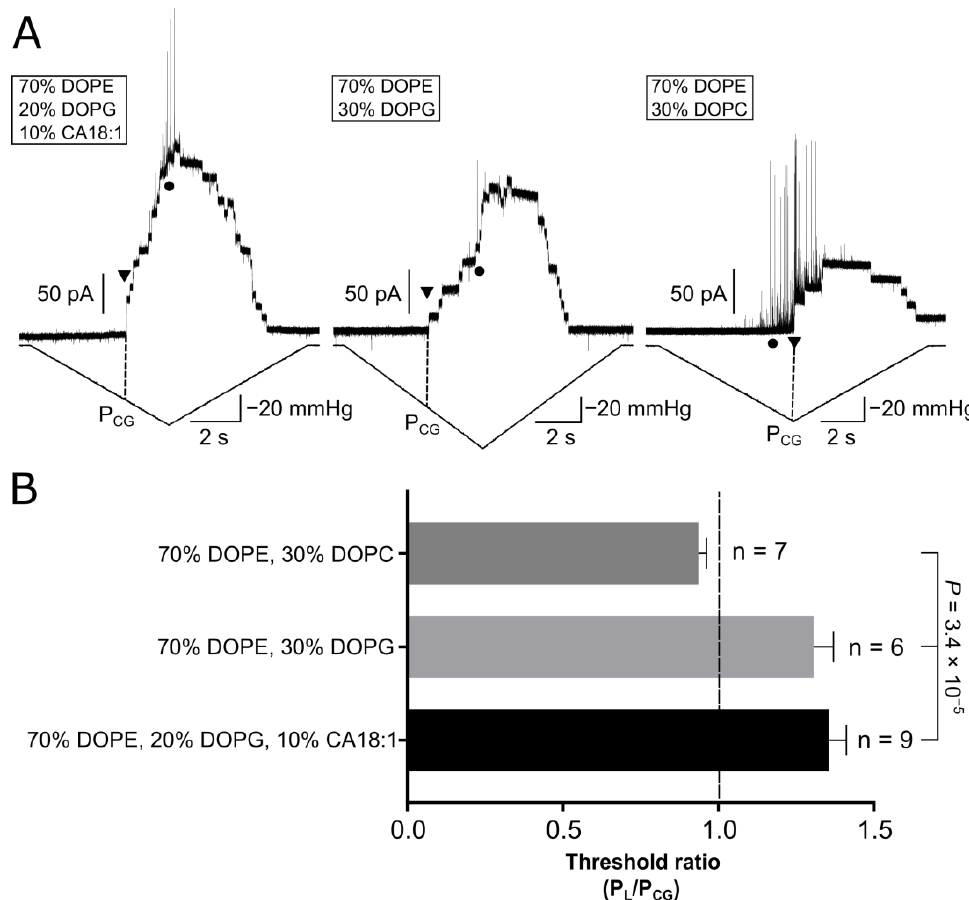
Figure 5. Mechanosensitivity of co-reconstituted MscCG with EcMscL in synthetic lipid liposomes. ( A ) Current recordings of purified MscCG and EcMscL co-reconstituted in liposomes made of different synthetic lipids of 70% DOPE, 20% DOPG, 10% CA18:1 ( left ), 70% DOPE, 30% DOPG ( center ), and 70% DOPE, 30% DOPC ( right ). Downward triangles show the first opening of MscCG, and circles show the first opening of EcMscL. P CG shows pressure level at the first opening activation for MscCG. ( B ) The comparison of the first opening threshold ratio between EcMscL and MscCG (P L /P CG ) in three different liposome preparations made of synthetic lipids. p -value was calculated by ANOVA (single factor) among three groups.